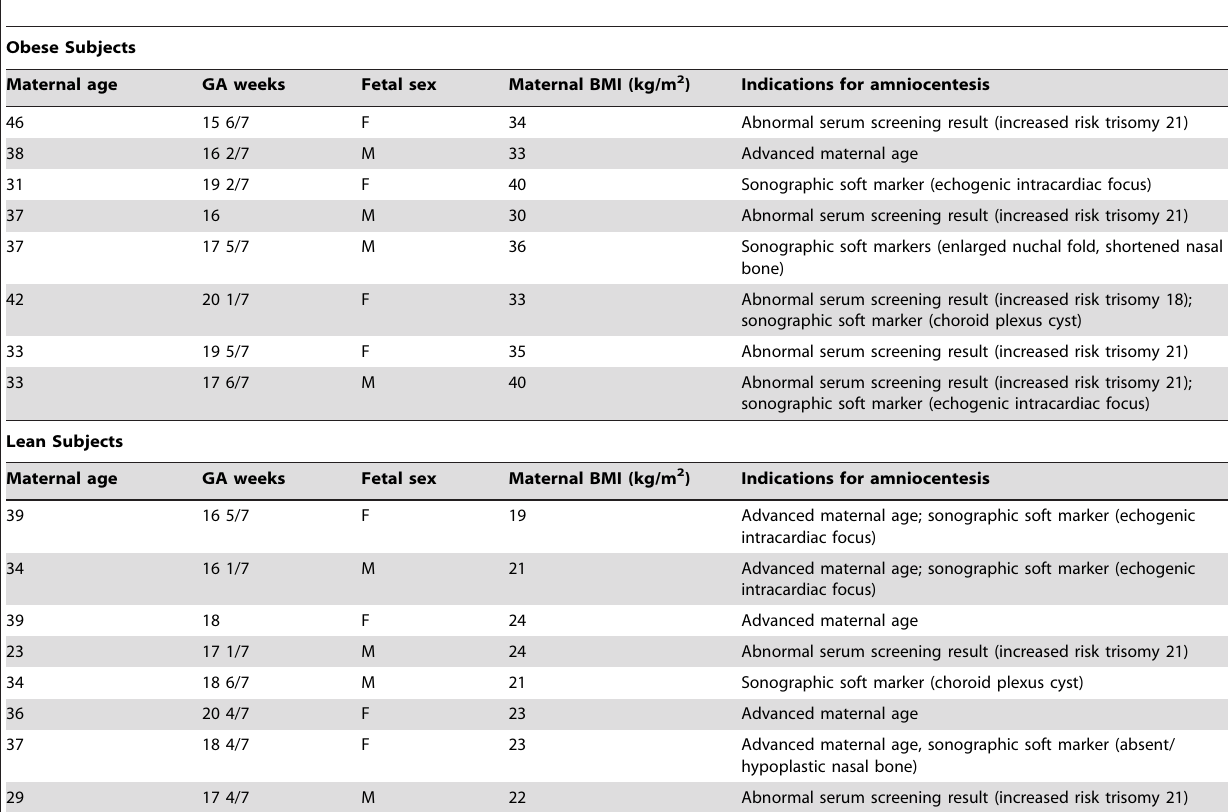
Table 2. Clinical characteristics of obese and lean